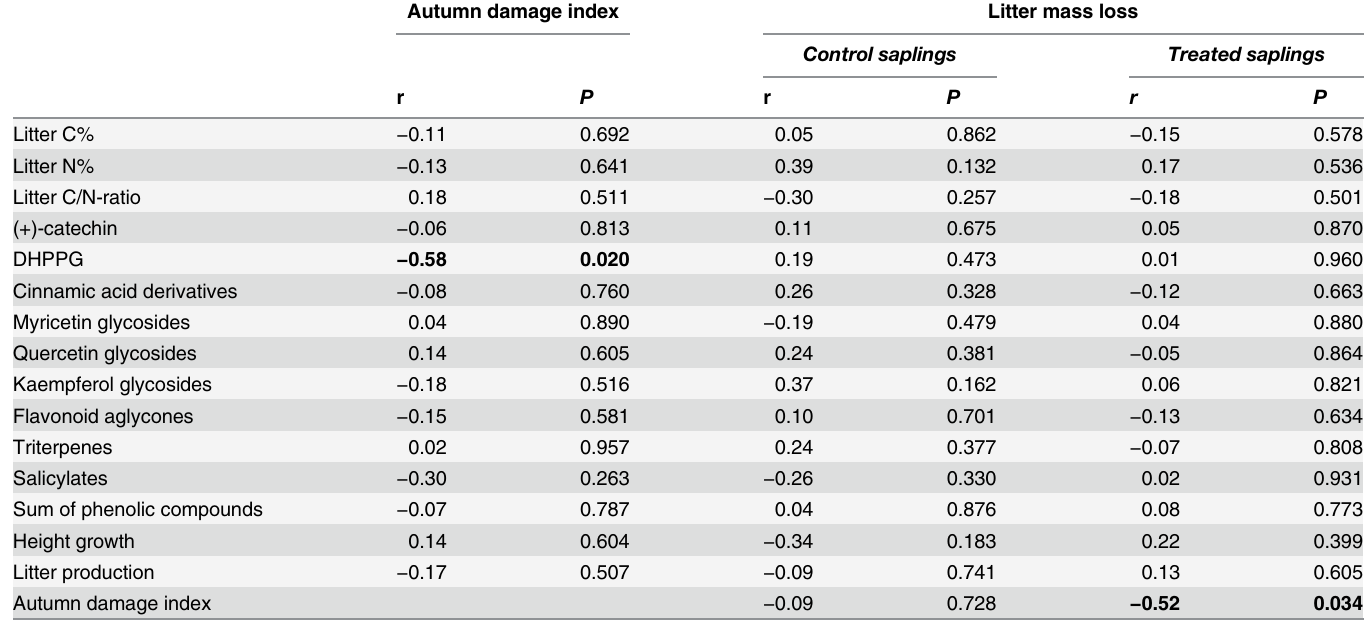
Table 4. Pearson correlation coef fi cients of genotype means of plant traits, autumn damage index (treated and control saplings combined because the genotype × insecticide effect was insigni fi cant) and litter mass loss (separately for treated and control saplings because the genotype × insecticide effect was signi fi